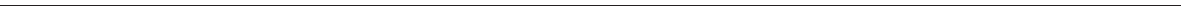
FIGURE 4 | (background control) as specified in Supplementary Table 4 and Supplementary Figure 10 . 10 4 cells of the P oi::pks1 strains, background control ( 1 P pks1 ), recipient strain phs1- (P pks1 ), pigment-deficient pks1- / phs1- and WT:A95 were dropped on solidified SD medium supplemented with glucose or galactose as carbon sources, and nitrate or yeast extract as nitrogen sources and incubated for 25 days in darkness. (D) The replacement of the endogenous pks1 promoter leads to different shades of melanin. Strains with reduced melanin formation in a carotenoid-containing background were generated by co-transformation of WT:A95 protoplasts with pAMA/ribo- pks1 PS4 and the two hygR-promoter constructs resulting in 1 P pks1::pks1 and Pgal1::pks1. Cells of the indicated strains were dispersed on solidified MEA and SDNG and incubated for 6 days in